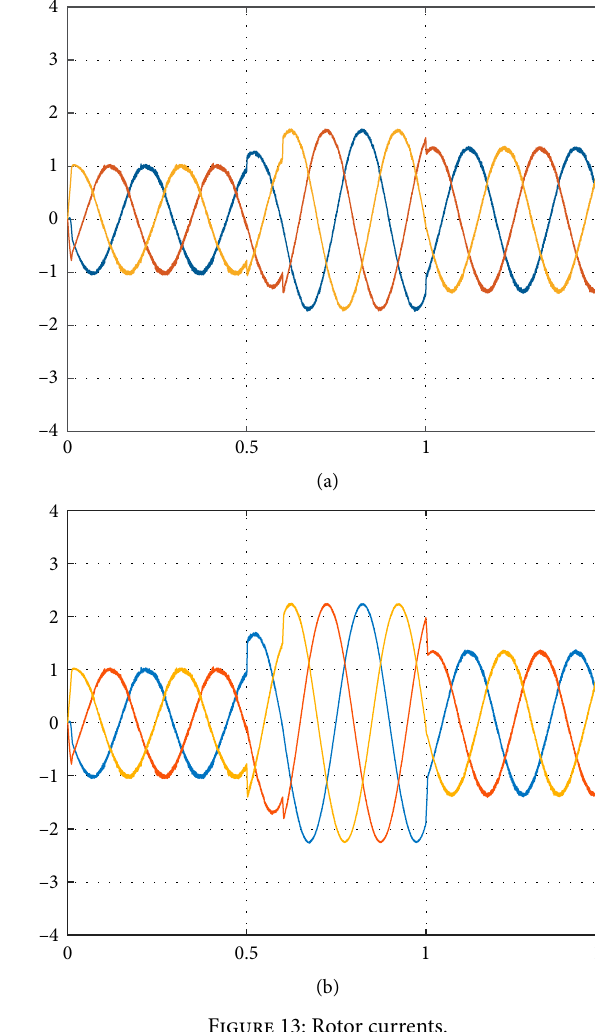
Figure 13: Rotor